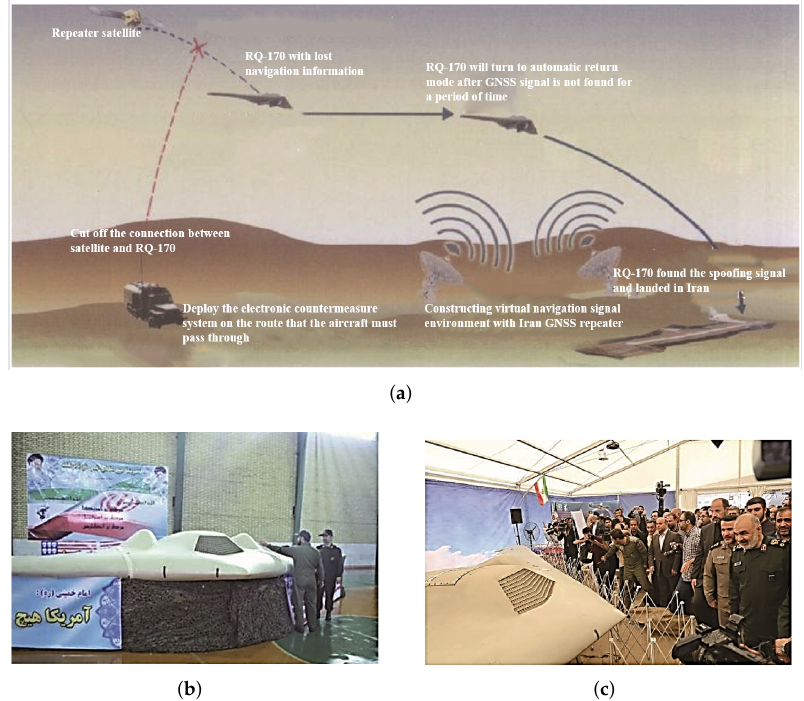
Figure 6. On 4 December 2011, Iran announced that it had captured a U.S. RQ-170 drone: ( a ) Simulation of Iran capturing RQ-170; ( b , c ) The pictures taken from the news report of Amer- ican drones captured by Iran. (https://www.guancha.cn/Project/2011_12_20_63306.shtml accessed on 16 June